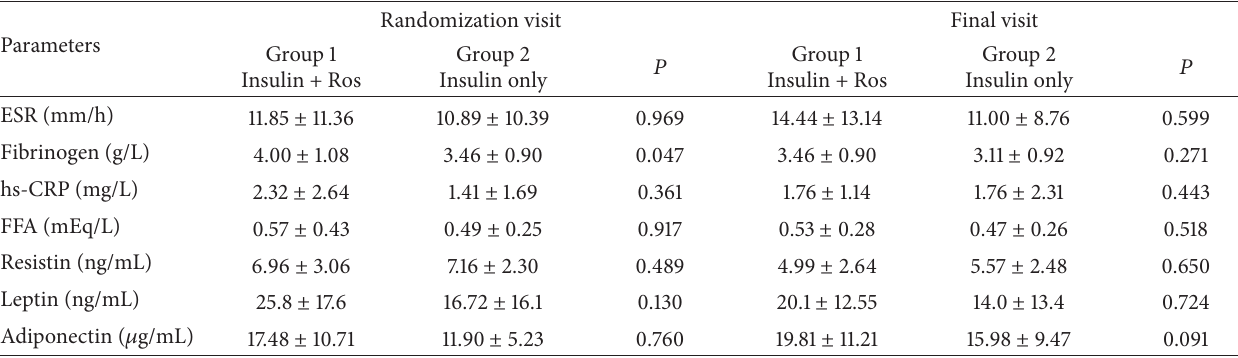
Table 3: Comparisons between the groups for inflammatory marker, FFA, and serum adipocytokine levels at baseline and at the final visit (week